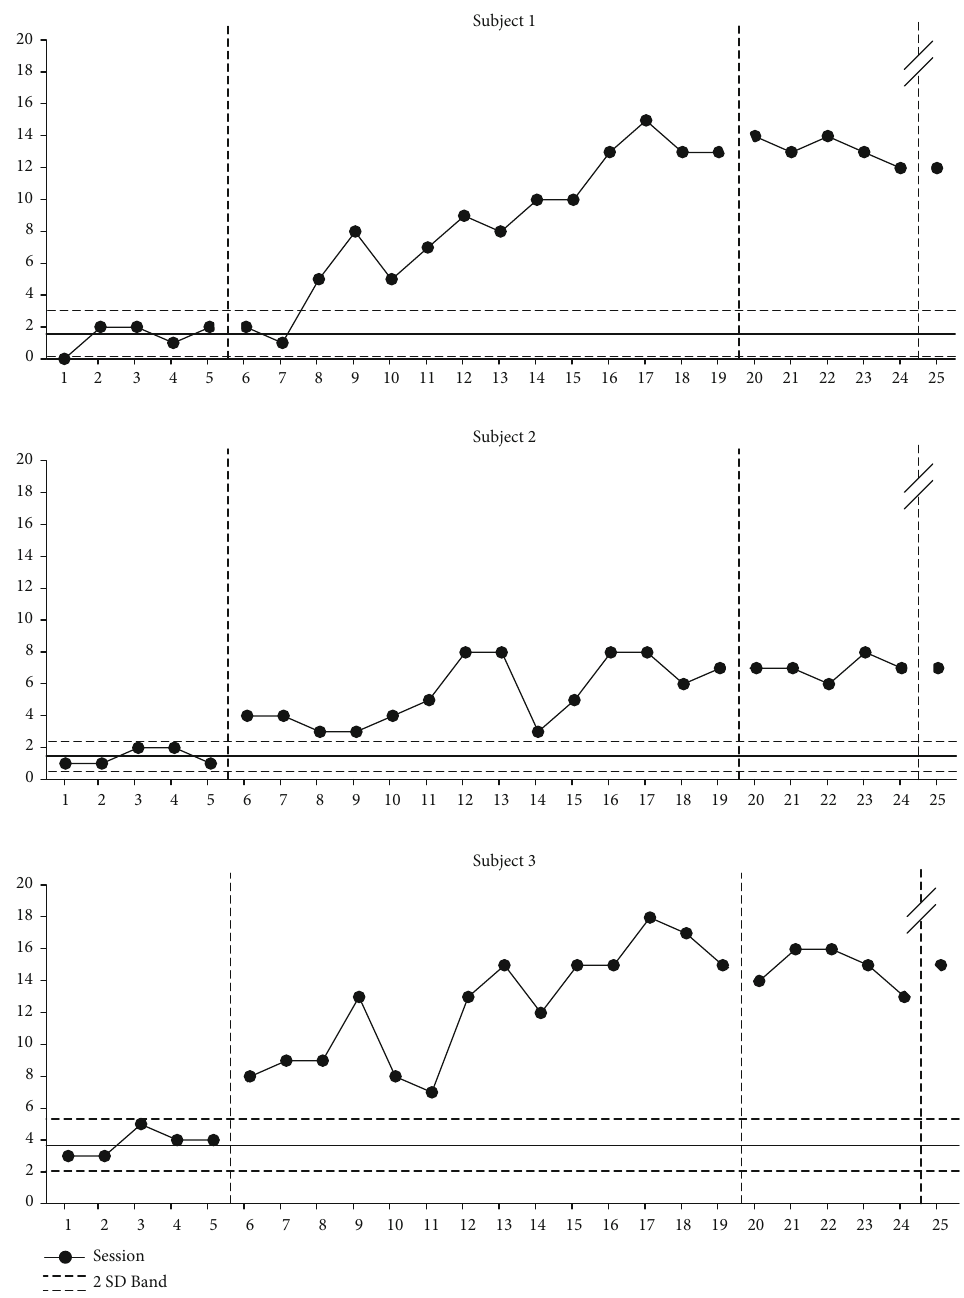
Figure 1: Changes in coordinates